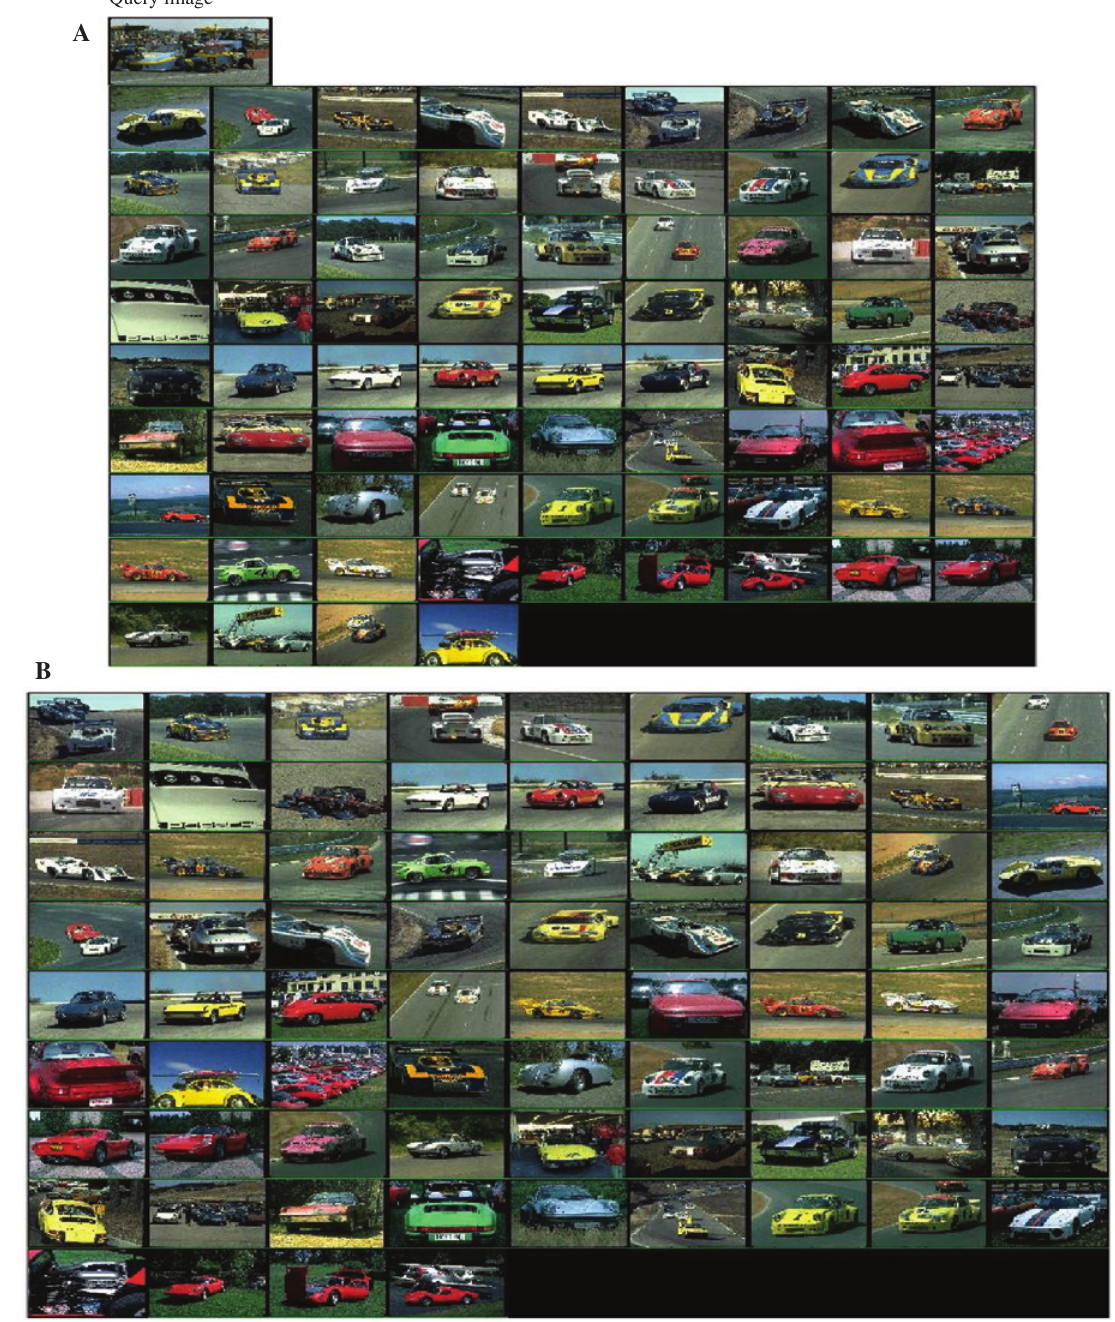
Figure 6: Retrieval Example Using Query Image